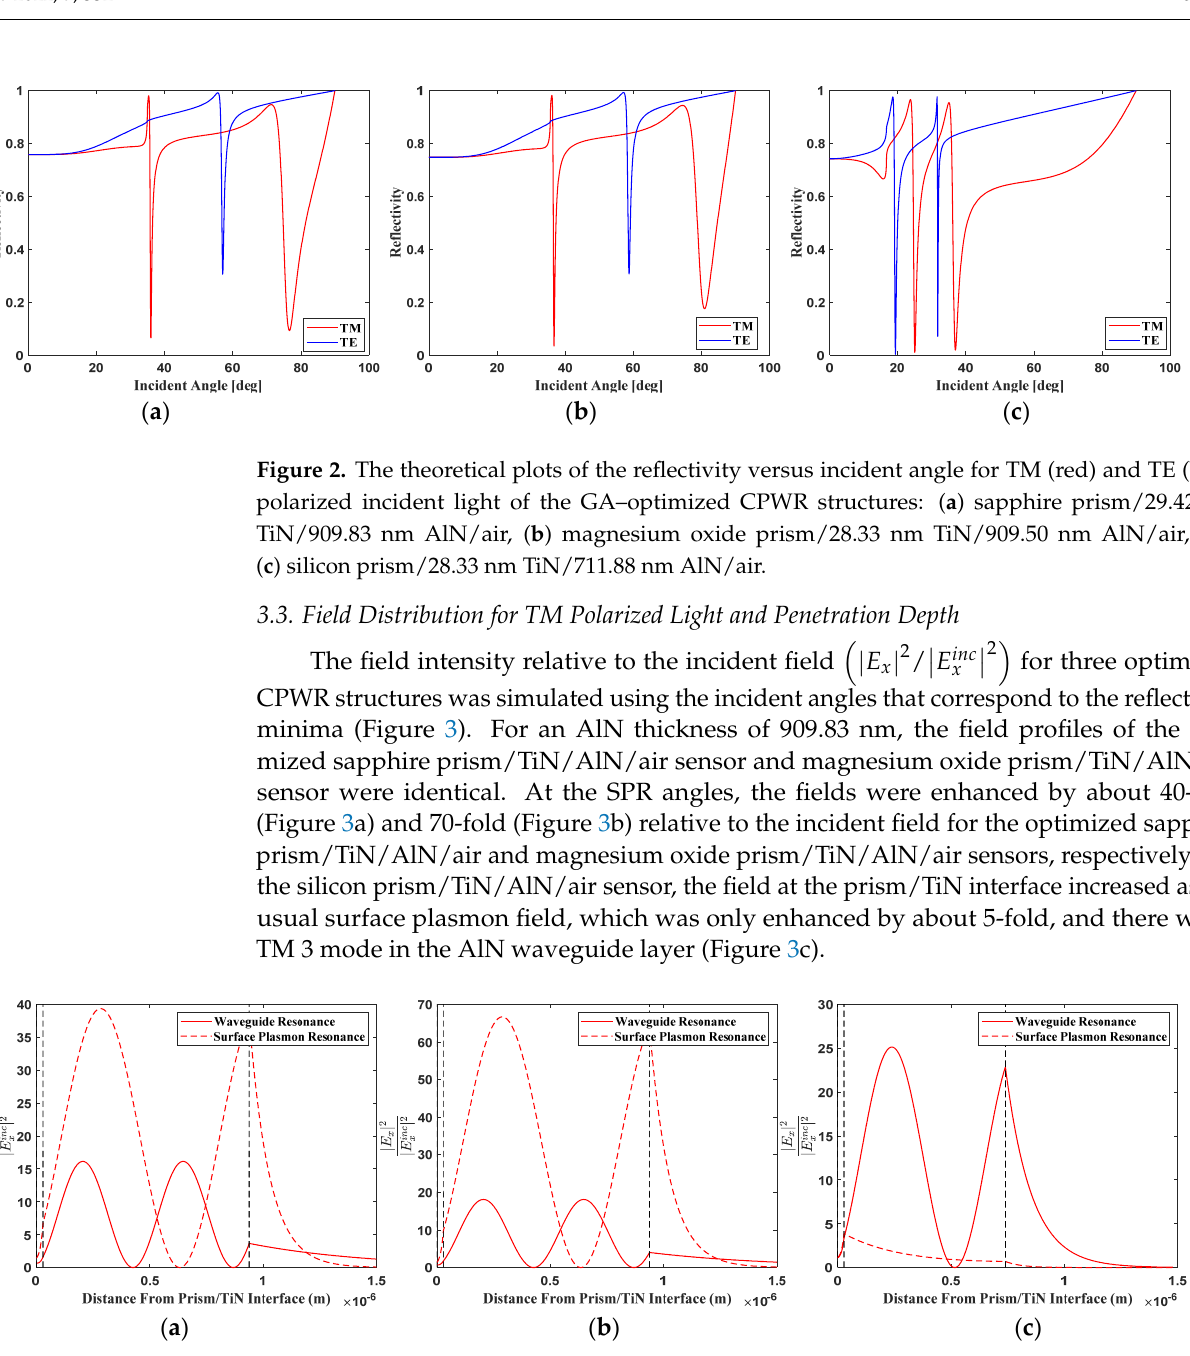
Figure 3. The electric field intensity for TM–polarized light for: ( a ) the sapphire prism/29.42 nm TiN/ 909.83 nm AlN/air sensor for incident angles of 35.91° (dash line) and 76.50° (solid line), ( b ) the magnesium oxide prism/28.33 nm TiN/ 909.50 nm AlN/air sensor for incident angles of 35.91° (dash line) and 76.50° (solid line), and ( c ) the silicon prism/28.33 nm TiN/ 711.88 nm AlN/air sensor for incident angles of 35.91° (dash line) and 76.50° (solid line).